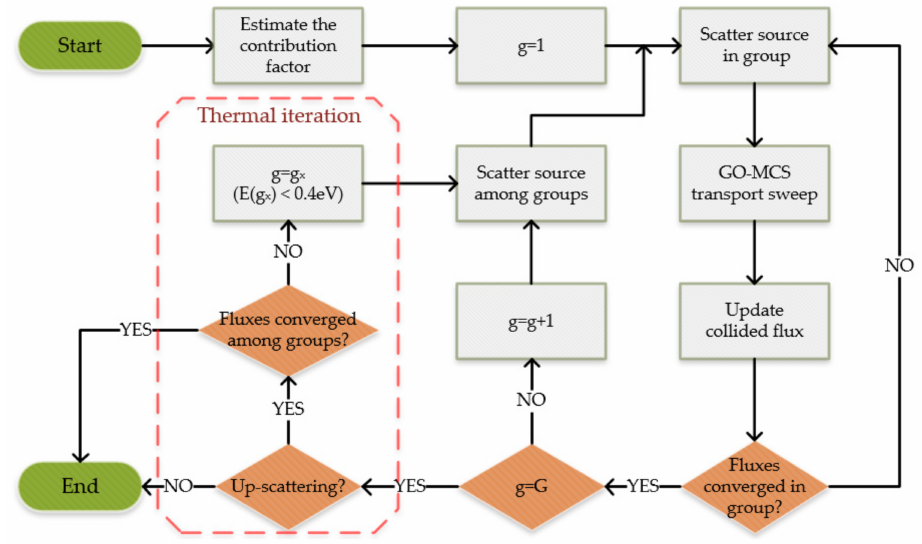
Figure 1. Flowchart of iteration for the GO-MCS